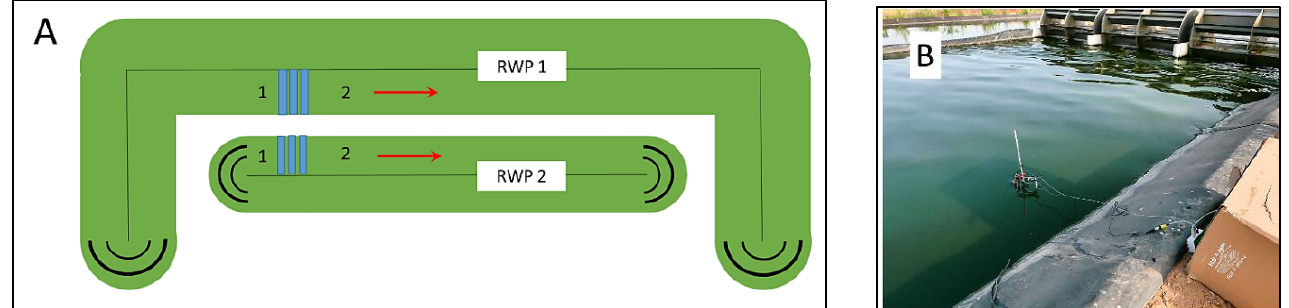
Figure 1. ( A ) Schematic diagram of raceway ponds RWP1 and RWP2 in the DEMO 5 plant con- in M é rida, Spain (GPS coordinates 38 ◦ 55 (cid:48) 52.1 (cid:48)(cid:48) N, 6 ◦ 23 (cid:48) 35.7 (cid:48)(cid:48) W). Points 1 and 2 indicate where pH, structed in Mérida, Spain (GPS coordinates 38°55 ′ 52.1 ″ N, 6°23 ′ 35.7 ″ W). Points 1 and 2 indicate dissolved oxygen (DO) concentration, and temperature were measured (1—before paddle wheel; 2—after where pH, dissolved oxygen (DO) concentration, and temperature were measured (1 — before pad- paddlewheel). Data was collected in bioreactors RWP1 and RWP2. ( B ) In-situ Chl fluorescence in dle wheel; 2 — after paddlewheel). Data was collected in bioreactors RWP1 and RWP2. ( B ) In-situ microalgae cultures grown in bioreactors was measured using a portable fluorimeter (Junior-PAM Chl fluorescence in microalgae cultures grown in bioreactors was measured using a portable fluo- fluorimeter, H. Walz, Effeltrich, Germany). The irradiance sensor and Chl fluorescence fiberoptics rimeter (Junior-PAM fluorimeter, H. Walz, Effeltrich, Germany). The irradiance sensor and Chl were submerged directly in the culture side by side in the photic zone (about 15 mm deep) in position fluorescence fiberoptics were submerged directly in the culture side by side in the photic zone 1 before the (about 15 mm deep) in position 1 before the paddlewheel.